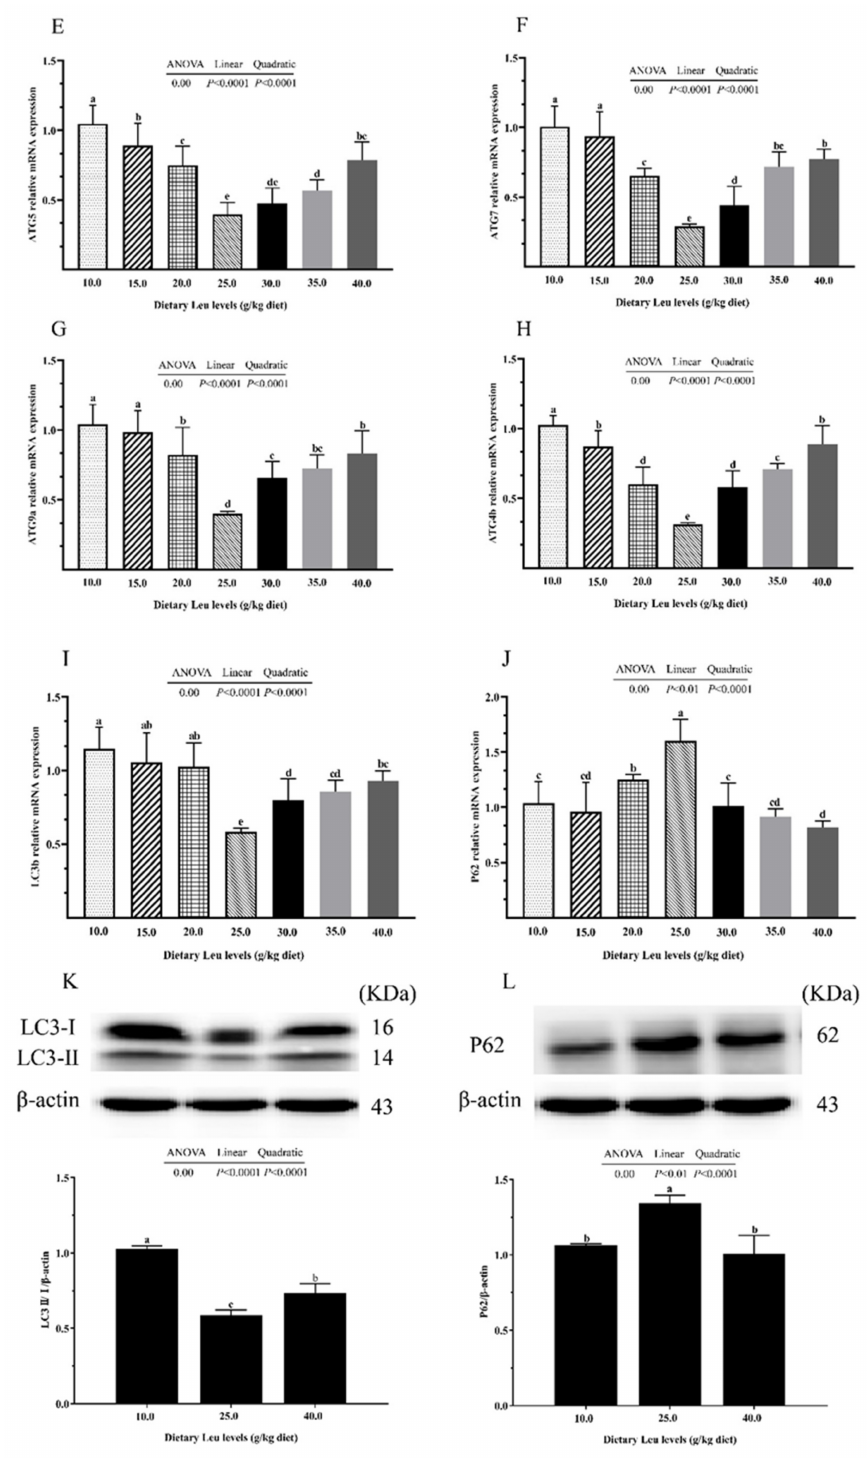
Figure 4. Effect of dietary Leu on autophagy-related gene mRNA expressions and protein levels in intestine of hybrid catfish fed diets with graded levels of Leu (g/kg) for 56 days. ( A , B , E – J ) The mRNA expressions of Beclin1, ULK1b, ATG5, ATG7, ATG9a, ATG4b, LC3b, and P62. ( C , D , K , L ) Protein levels of Beclin1, ULK1, LC3II/I, and P62. Results are represented as means ± SEM (n = 3 × 6). Duncan’s multiple range test was used to detect significance. Different superscripts above the bars indicate significant differences ( p <